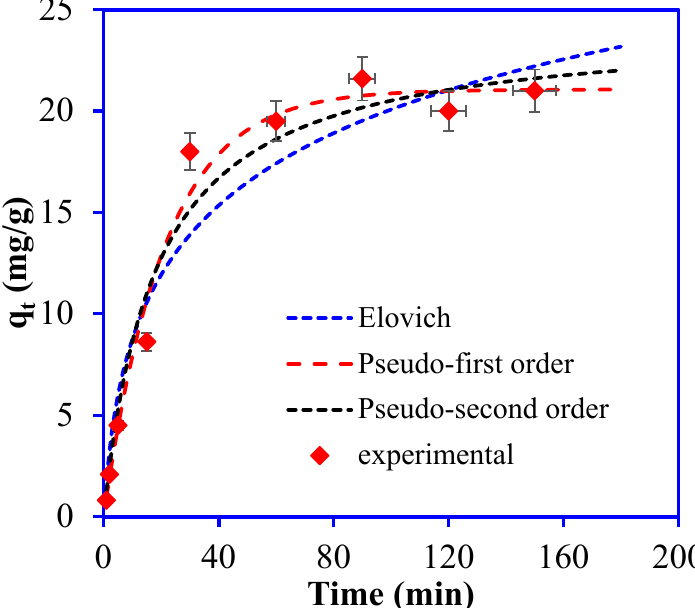
Figure 8. Kinetics plots for the adsorption of Br − ions onto PANI/GO@GTW from aqueous solution (solution pH: 3, Br − conc.: 50 mg/L, time: 150 min, solution volume: 20 mL, and adsorbent mass: 0.05 g). Table 1. Adsorption kinetics parameters for Br − onto GO/PANI@GTW. Kinetic Model